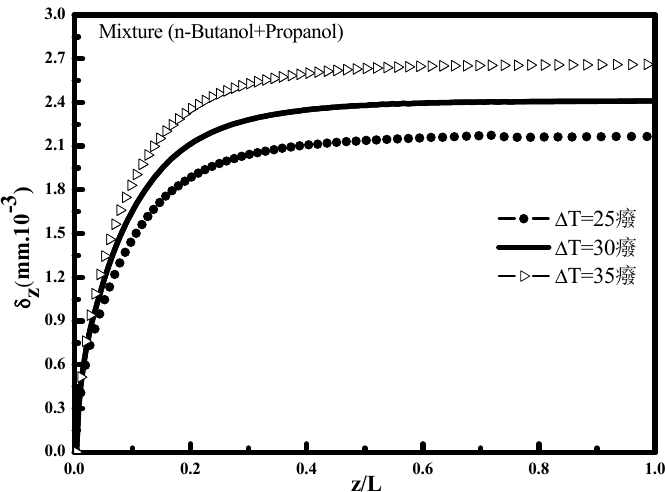
Figure 4. Variation of the mixture mass fraction along the tube for different Δ T.